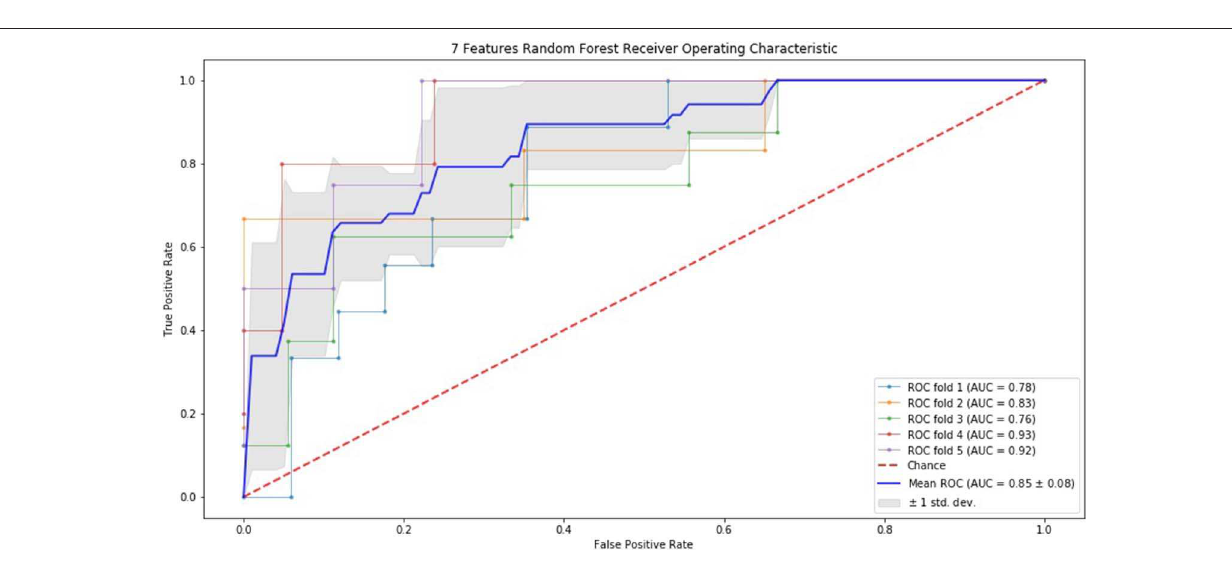
FIGURE 6 | ROC of 5-fold cross validation results of RF. The mean AUC of 7 features was 0.85 ±